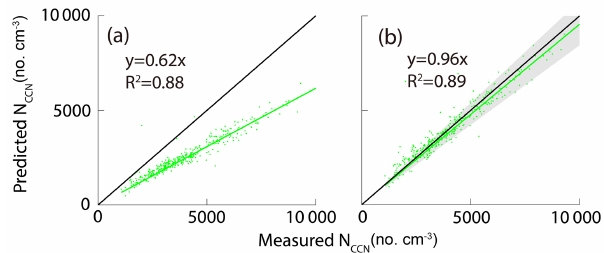
Figure 12. The relationship between measured N CCN and predicted N CCN at SS 0.1% based on size-resolved chemical composition (b) . The shadow area represents using κ ∗ org (a) and κ ∗ org and σ ∗ s / a the variation of the linear fit using the σ s / a values from 0.054 to 0.062Nm − 1